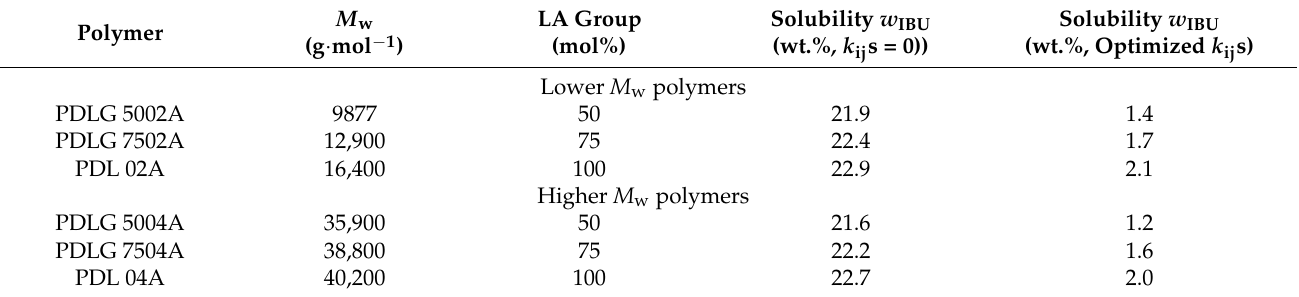
Table 4. IBU solubility w IBU (wt.%) in PLA/PLGA polymers at 25 ◦ C calculated using PC-SAFT EOS with k ij s = 0 and optimized k ij